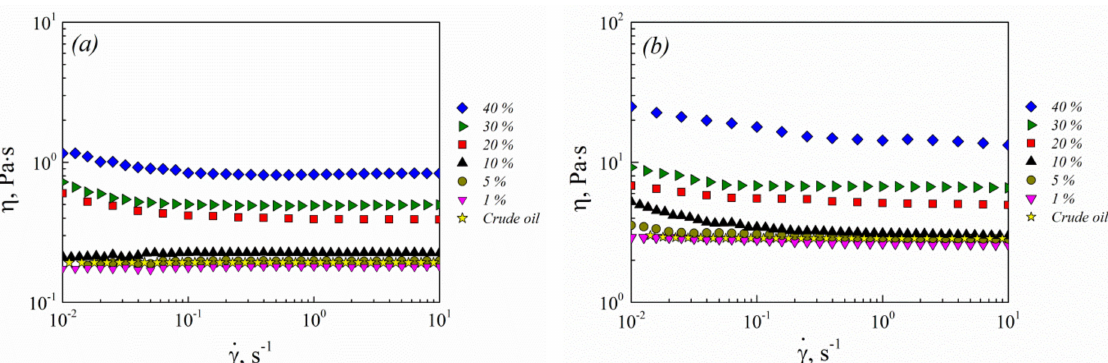
Figure 5. Flow curves of water-in-crude oil emulsions obtained at 30 ◦ C ( a ) and 0 ◦ C ( b ). Aqueous phase volume fractions are presented on graphs.